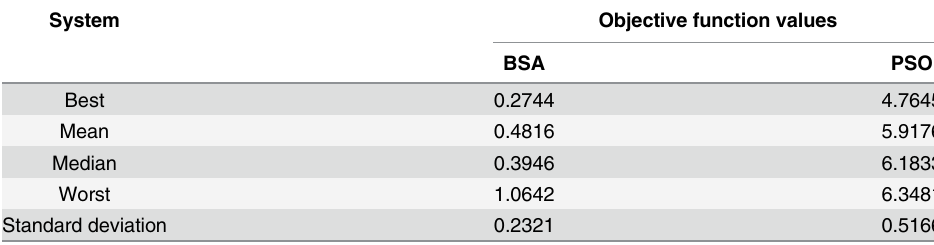
Table 2. Best solutions (cost values) obtained by each algorithm from 15 individual